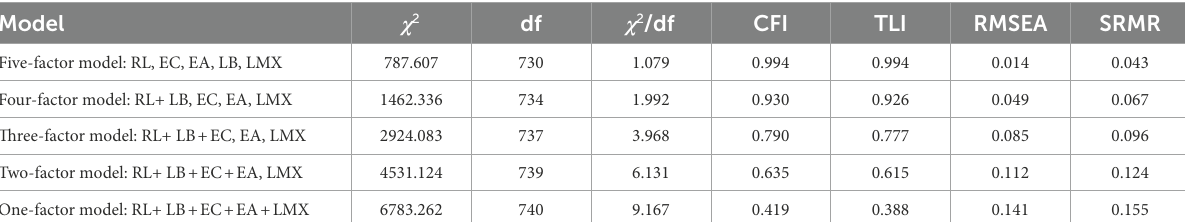
TABLE 2 Confirmatory factor